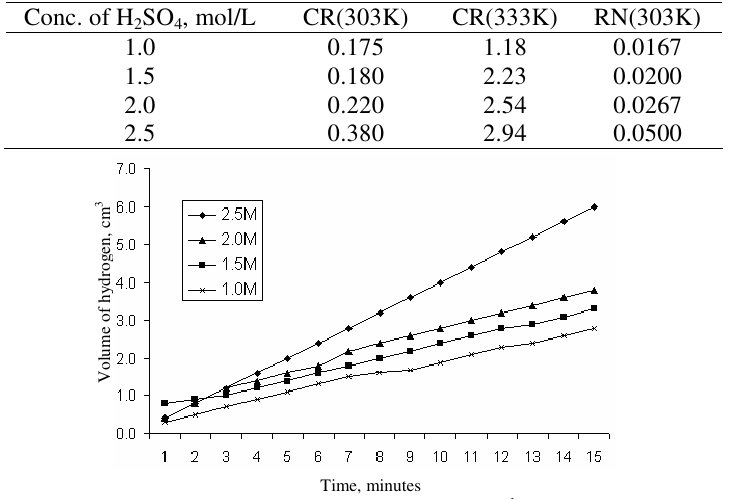
Figure 1. Variation of the volume of hydrogen gas evolved i th time for the corrosion of mild steel in various concentrations of tetraoxosulphate(VI)